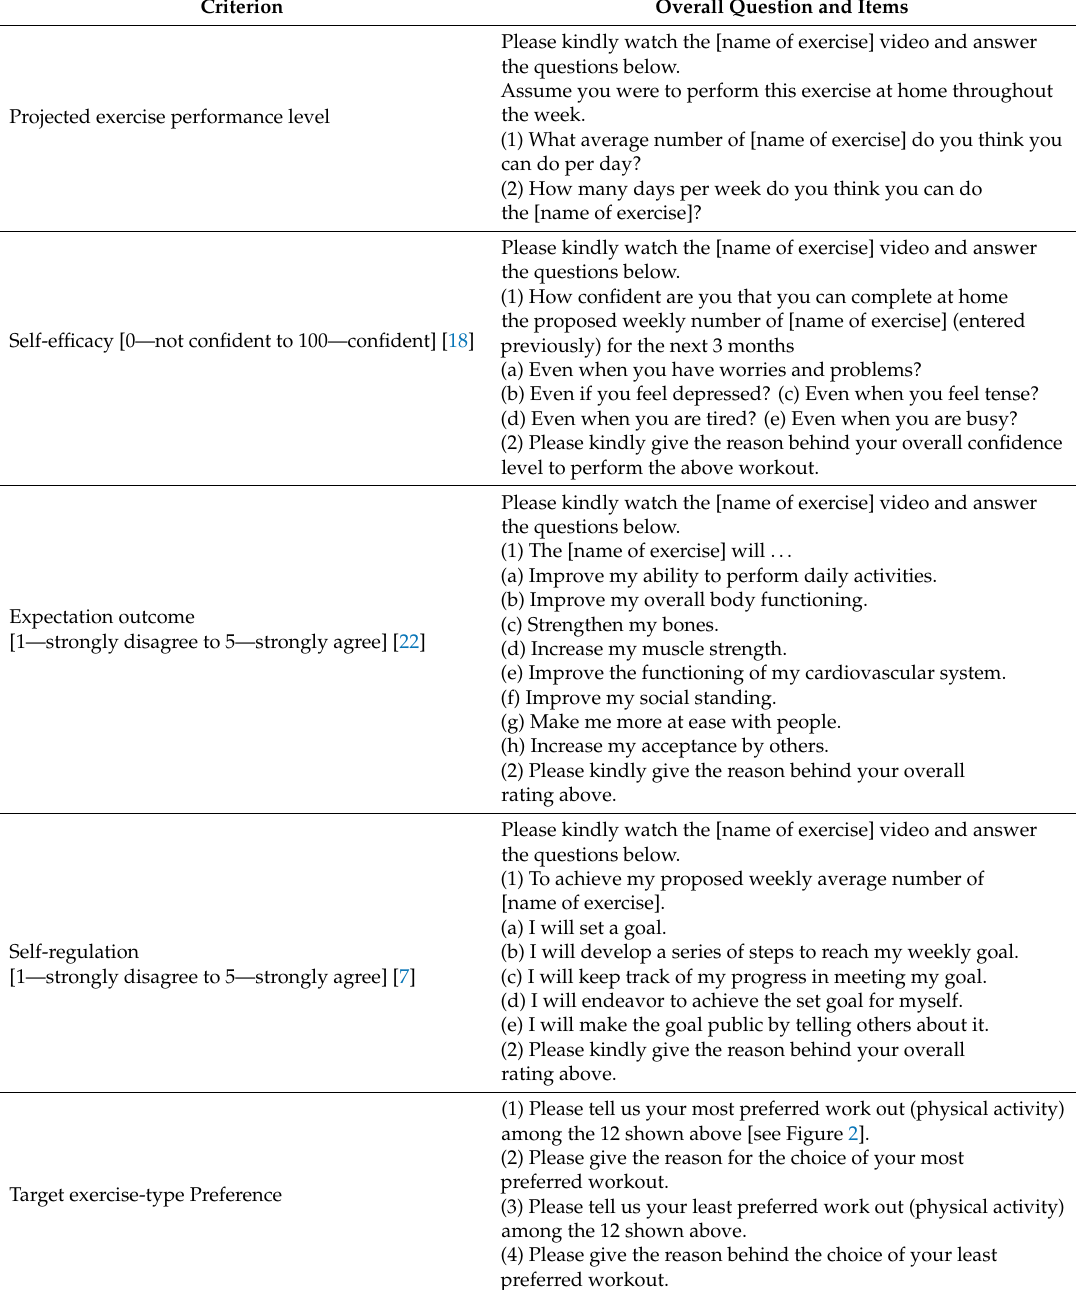
Table 2. Instruments used for measuring social cognitive